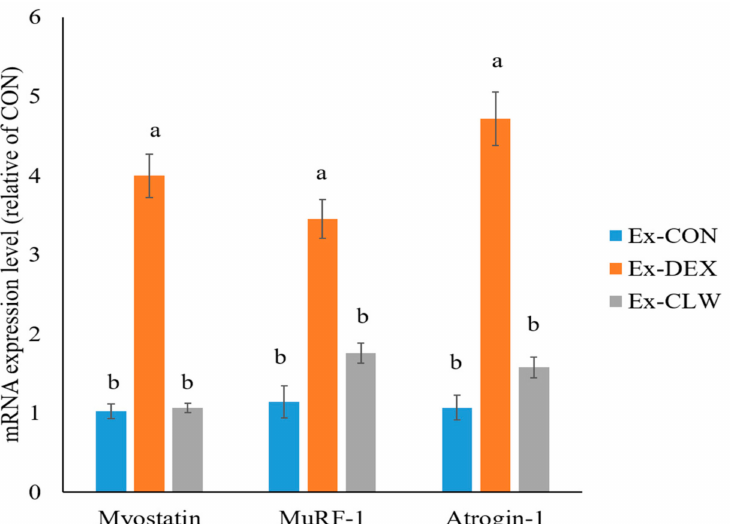
Figure 3. Effect of CLW on the mRNA expression level of the muscle atrophy gene. RT-PCR analysis of the muscle atrophy genes, myostatin, MuRF-1, and Atrogin-1 in the gastrocnemius muscle. Ex- CON, DW supplementation, and saline IP injection group; Ex-DEX, DW-supplementation and DEX (1 mg/body weight/day) IP injection group; Ex-CLW, CLW supplementation (1 g/body weight/day), and DEX IP injection group. Data are expressed as mean ± SE for eight mice in each group. Values with different superscripts indicate a significant difference among groups based on Duncan’s multiple range test ( p < 0.05).